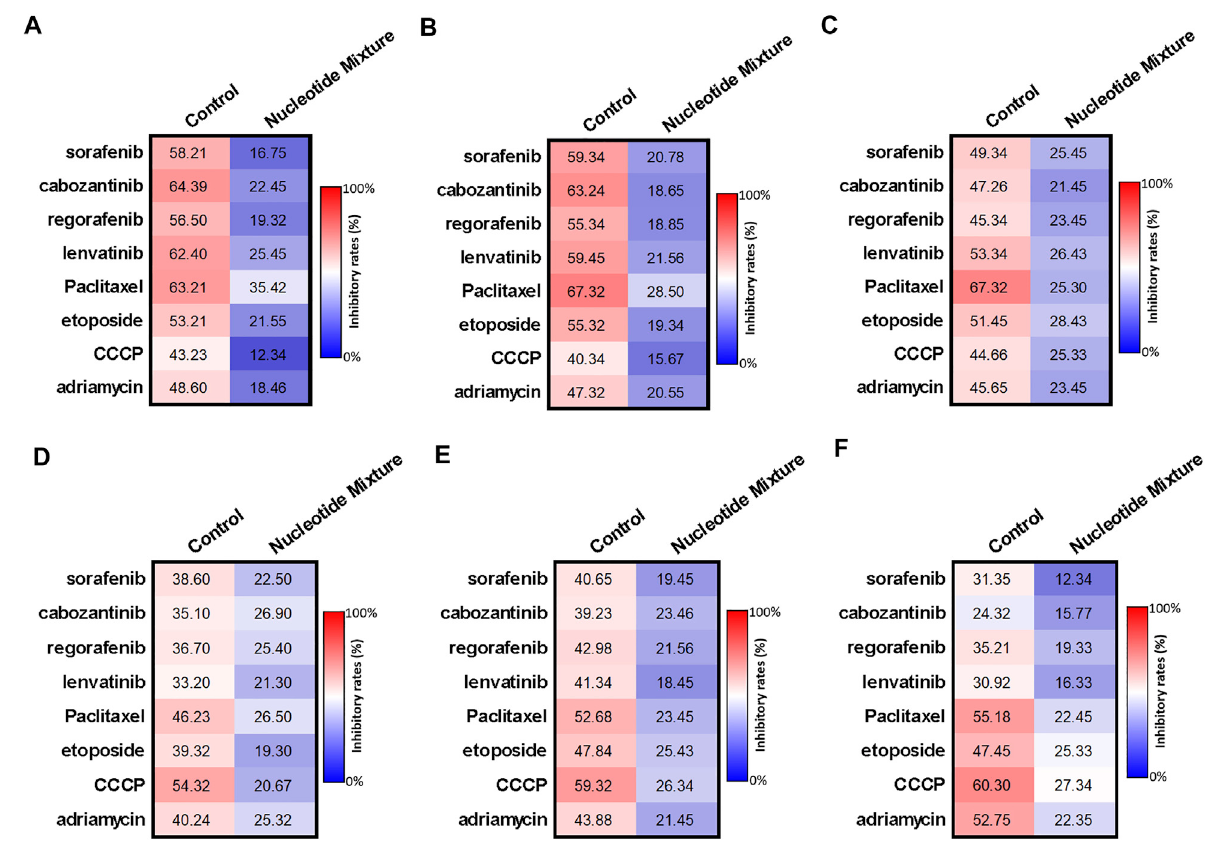
Frontiers in Pharmacology |